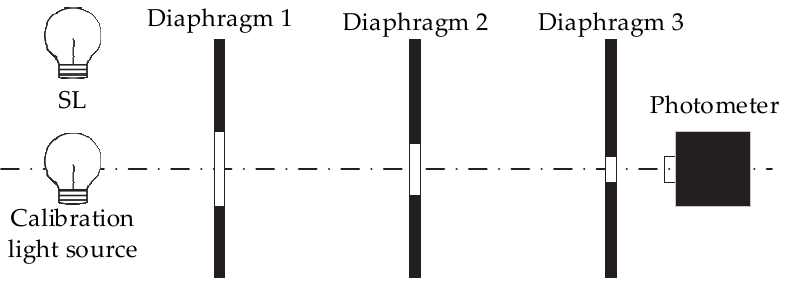
Figure 2. Equidistance method to measure light source stability.